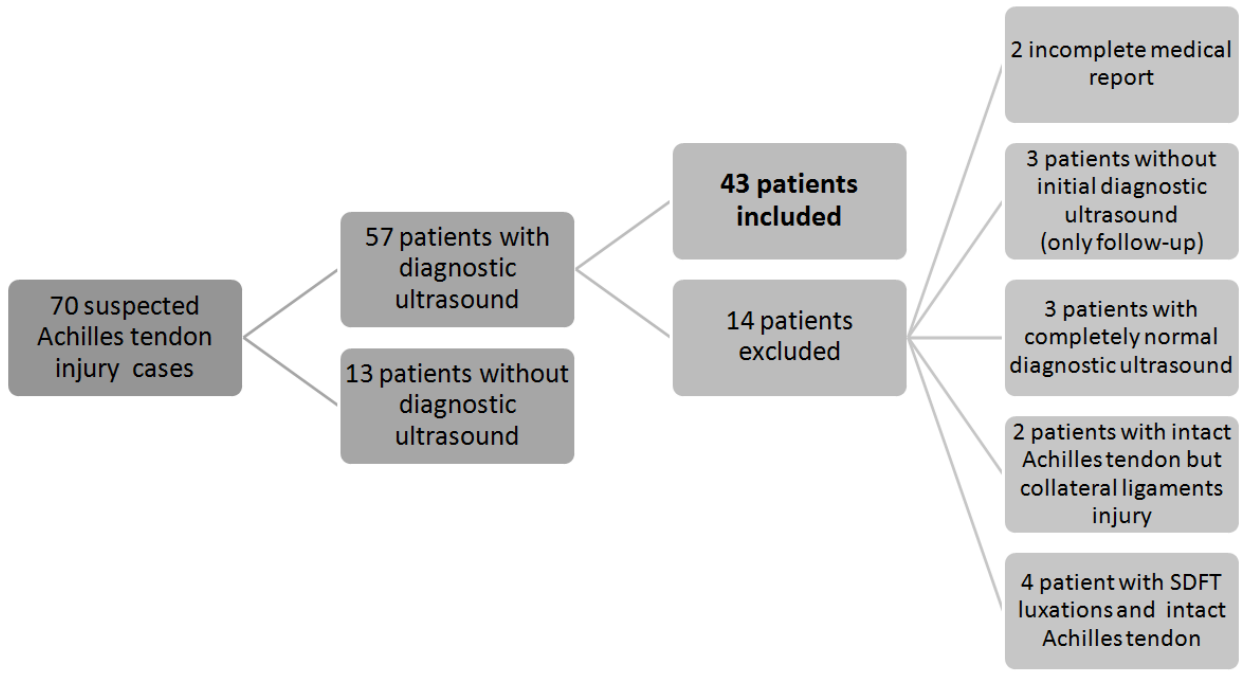
Figure S1 : Organigram of the Case Selection